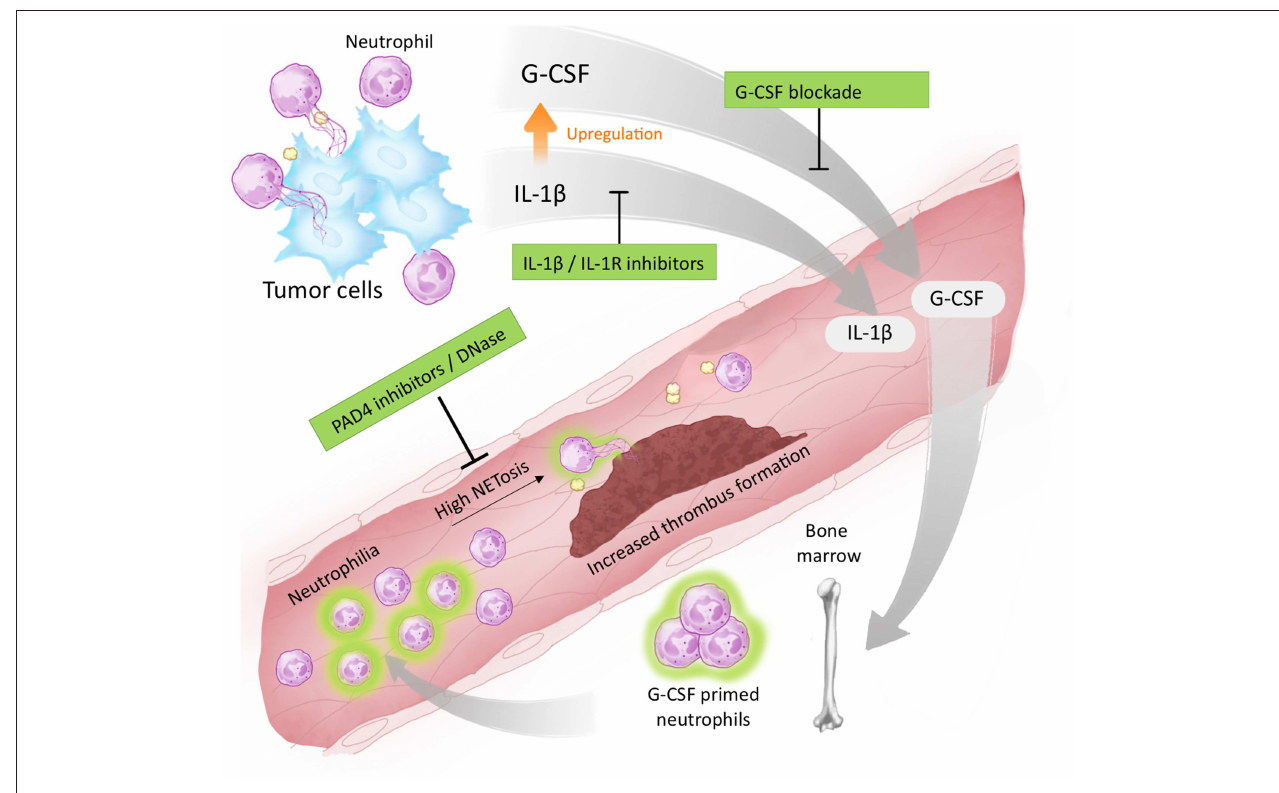
FIGURE 6 | Proposed targets for antithrombotic therapy in NET-dependent thrombosis. The development of a thrombotic state in cancer patients is dependent on tumor-induced systemic alterations. One possible mechanism involves the elevation of circulating levels of IL-1 β and G-CSF as well as neutrophilia. G-CSF acts in an endocrine fashion, stimulating the bone marrow to produce and export neutrophils to the bloodstream. G-CSF (and possibly IL-1 β ) prime neutrophils toward NETosis facilitating the establishment of a NET-dependent prothrombotic state. Blockade of IL-1 β expression, or signaling through IL-1R, reduces G-CSF levels attenuating the thrombus formation. Therapies targeting NETs formation (such as PAD4 inhibitors) or destroying already formed NETs (such as DNase I) have also been proposed to attenuate cancer-associated